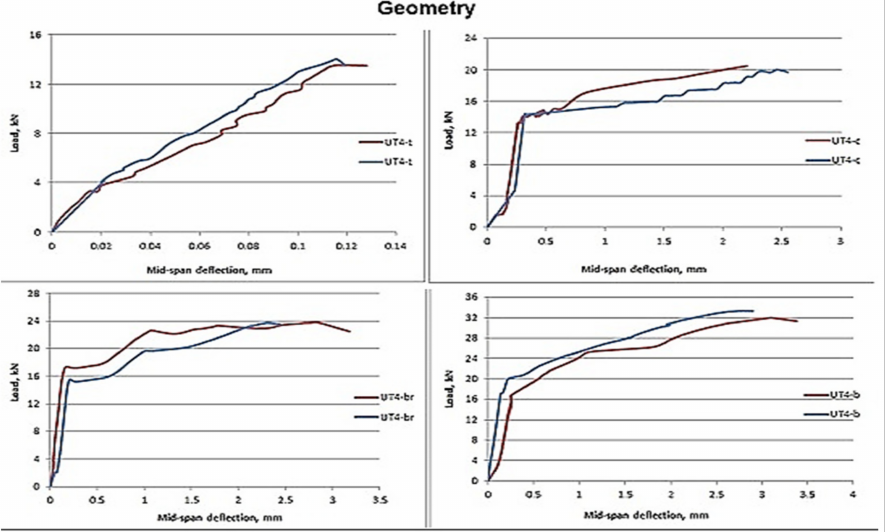
Figure 15. Mid-span load-deflection of uni-axial tows with different geometries and the volume fraction of 0.31%.